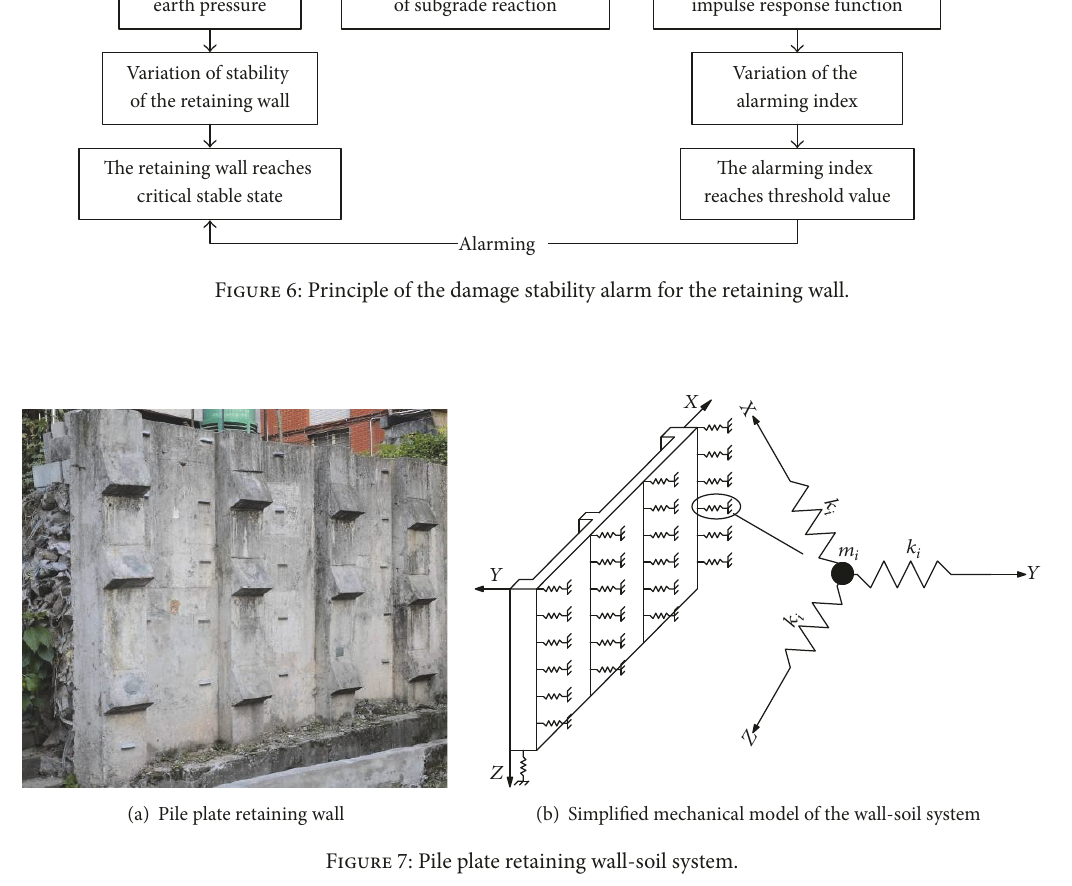
Figure 7: Pile plate retaining wall-soil system.